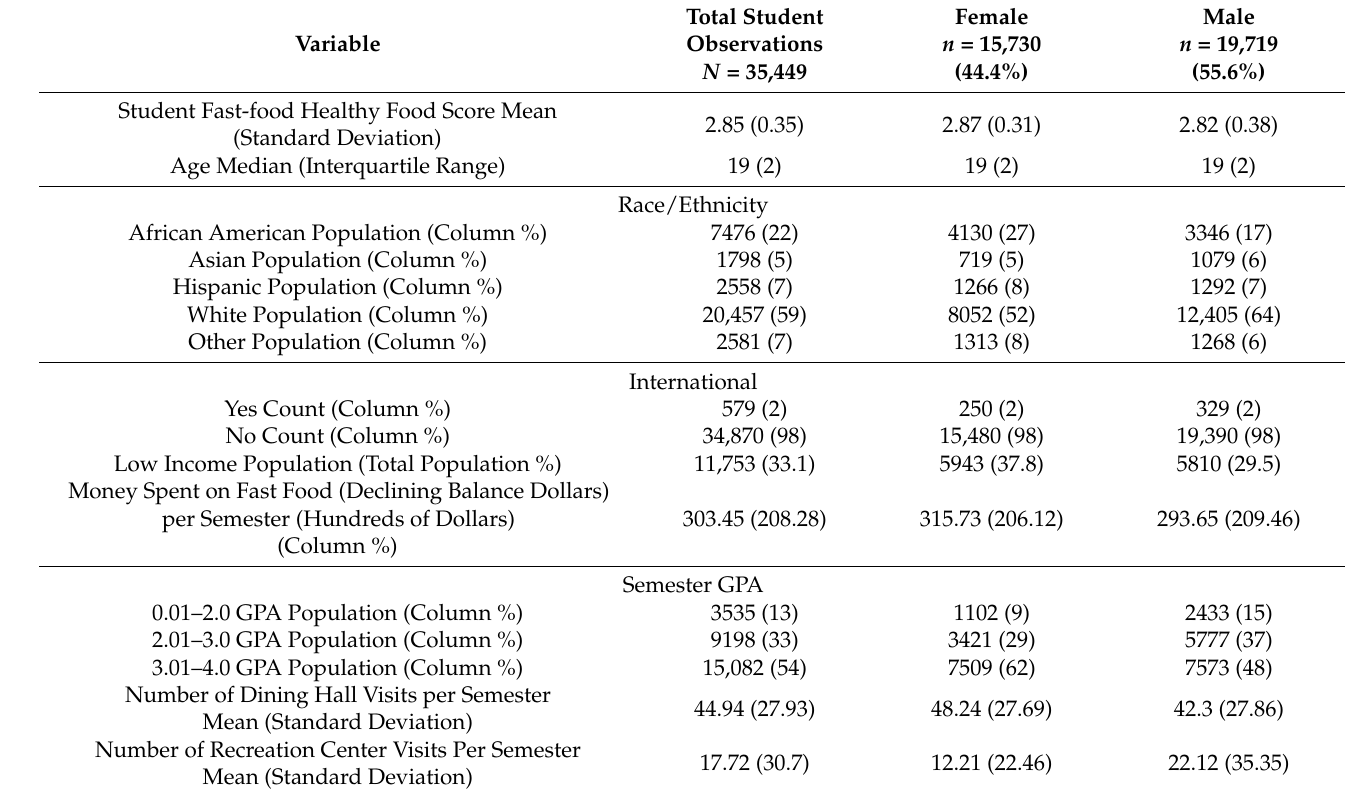
Figure 2. Distribution of food and beverage items (N = 3781) by Fast-Food Health Score. Between fall 2016 and spring 2019, meal plan students spent $10,757,110 with DBD generated from 1,593,235 transactions. Table 2 shows the characteristics of the students in the study. Students spent on average $303 per semester with DBD. Most students self- identified as White (59%) or African American (22%). Half of the students (54%) had a GPA of 3.01–4.0. Finally, 33% of students on the meal plan were low income (Table 2). Bivariate analyses confirm that the mean Student Average FFH score for females is slightly higher than the mean Student’s Average FFH score for males (2.87 compared to 2.82, with p ≤ 0.0001), Figure 2. Table 2. Student Average Fast-Food Healthy Food and Beverage Score (FFHS) and Student Demographic, Economic, and Behavioral Characteristics 2016–2019, Stratified by Sex N = 35,449.